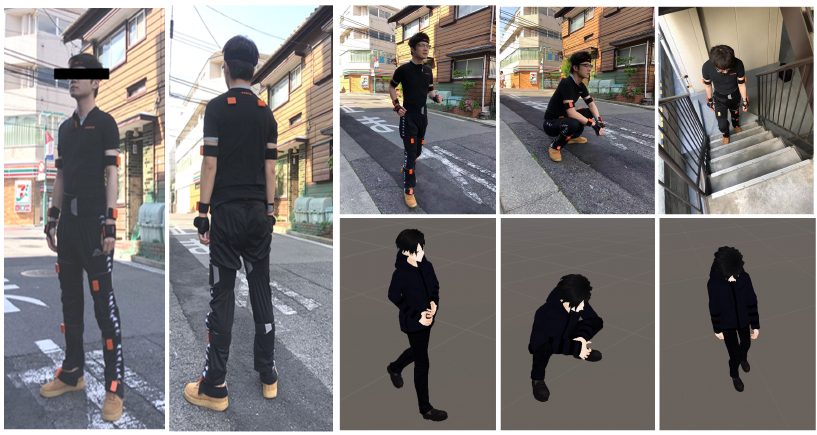
Figure 6. The 3D virtual human reconstruction. The subject is requested to wear the off-the-shelf MoCap suit (Xsens MVN). The related “.fbx” file can be converted and then applied to the virtual humanoid avatar to reconstruct the motion process. (The figures only present one frame of the whole process so there may be some inconsistency between the real and virtual